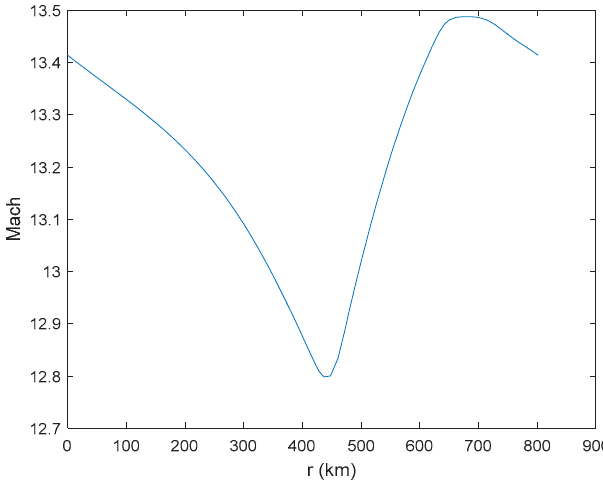
Figure 7. Optimal Mach number at the initial altitude of 43 km.